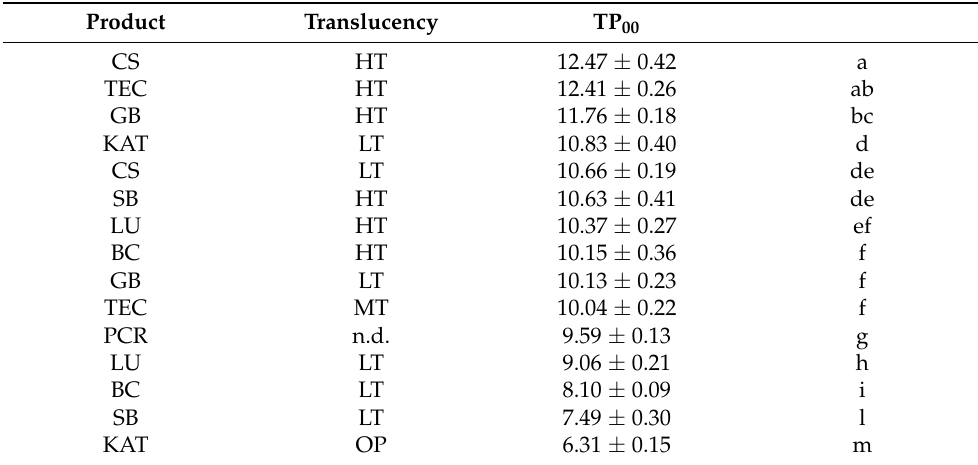
Table 4. Translucency Parameter 00 (TP 00 ) of the materials tested. Materials are listed from the highest TP 00 (more translucent) to the lowest TP 00 (opaquer). Table 3. Translucency Parameter (TP) of the materials tested. Materials are listed from the highest TP (more translucent) to the lowest TP (opaquer).